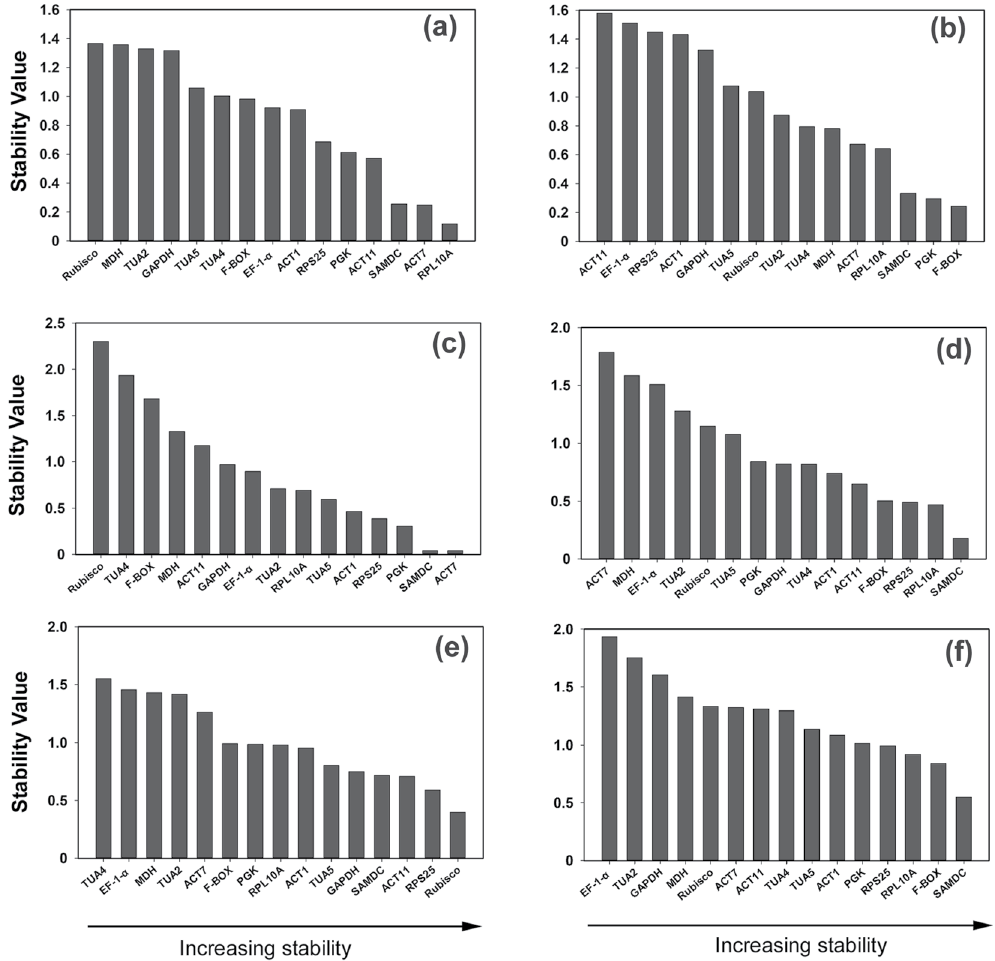
Figure 4. The stability value of 15 candidate reference genes calculated by NormFinder. The lower value indicated the higher stability of gene expression. (a ) Tissue; ( b ) developmental stage; ( c ) photosynthetic cycles; ( d ) drought treatment; ( e ) cold treatment; ( f ) all of the samples in our given